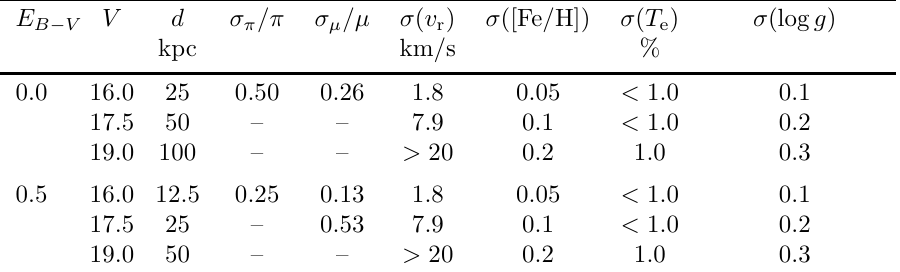
Table 2. Predicted accuracies versus magnitude for kinematical